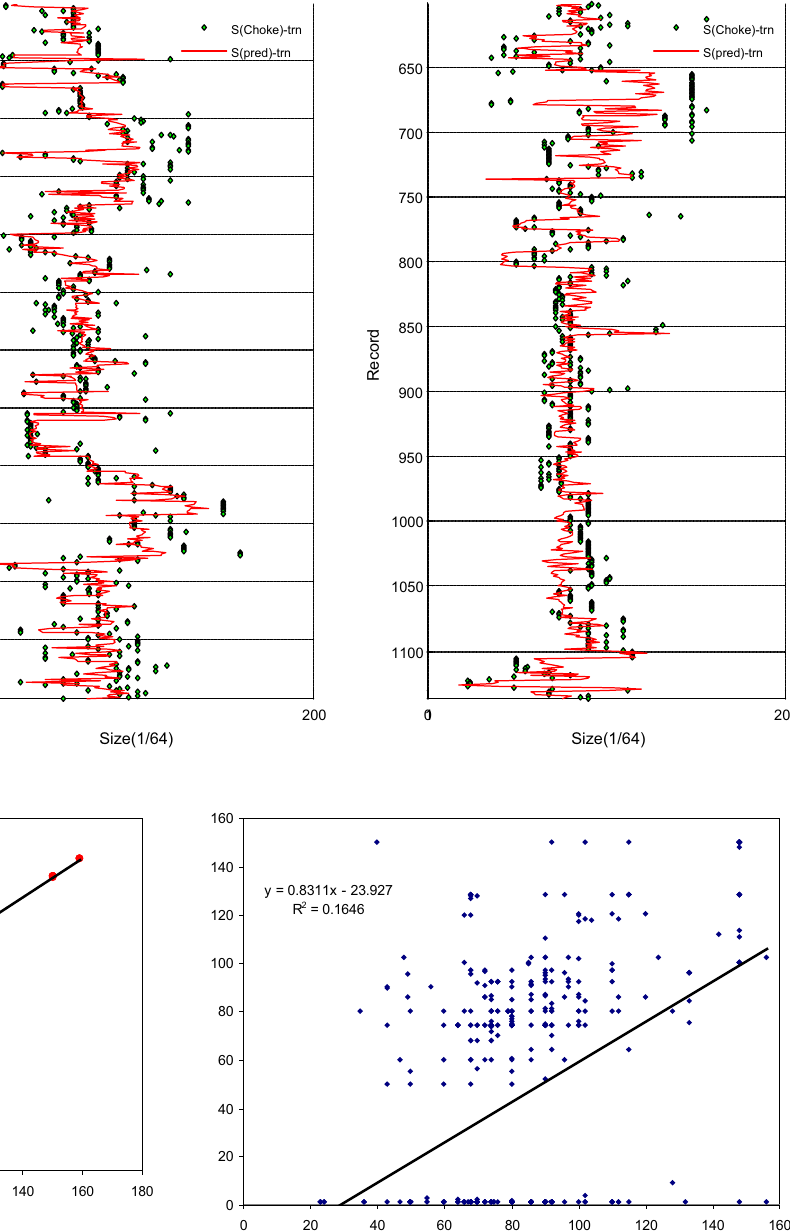
Fig. 17 Actual versus predicted choke size for RBF model training (spread = 0.01) Fig. 18 Actual versus predicted choke size for RBF model testing (spread =